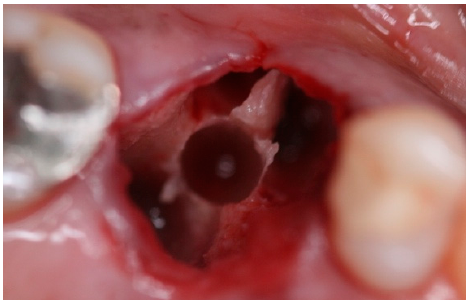
Figure 13. Intra-oral oclusal view of #16 site after extraction and septum expansion by Osseodensi- fication bone instrumentation.